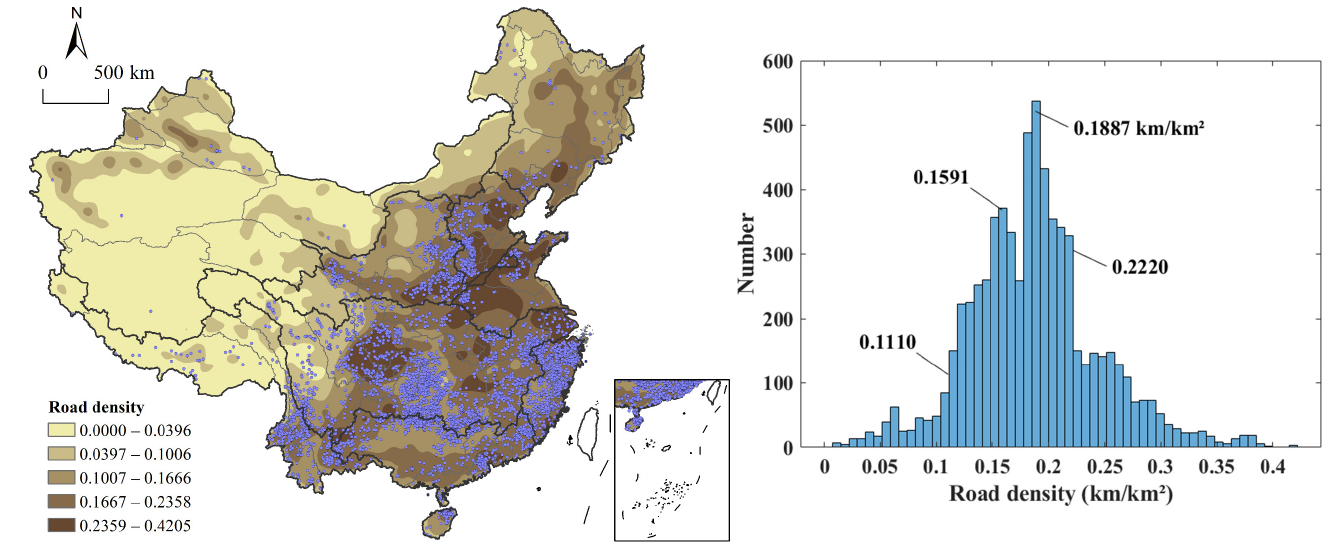
Figure 8. Relationships between traditional villages and road density in China.